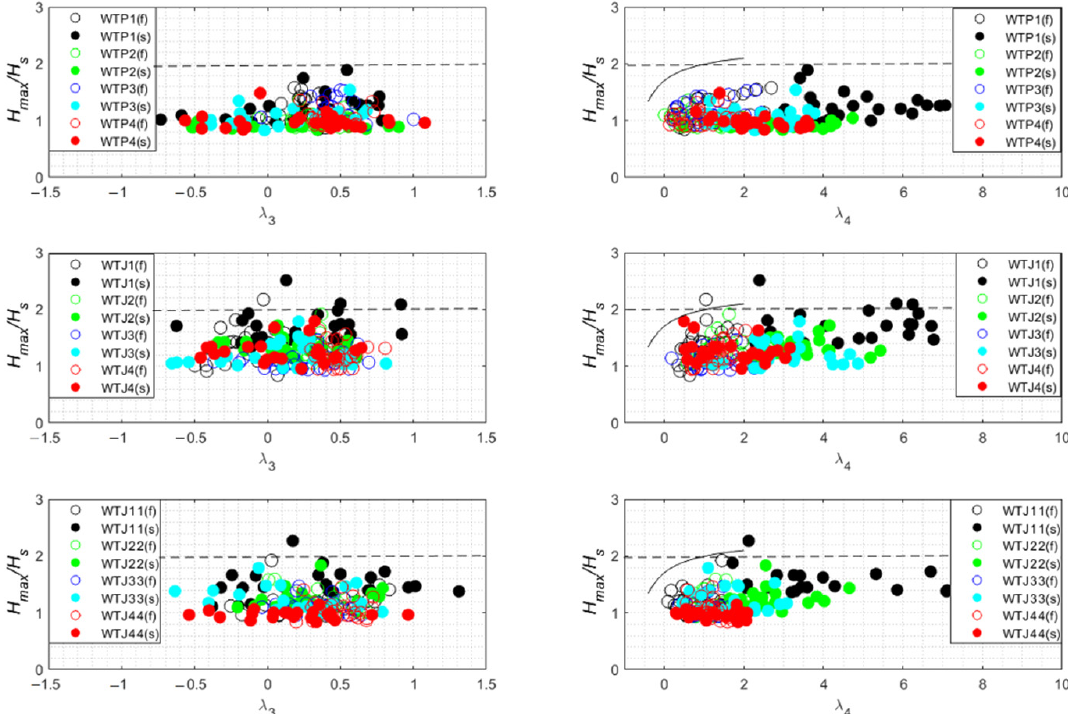
Figure 9. Relationship between the maximum wave height H max / H s , skewness 3 and kurtosis λ 4 on the flat and on the sloping bottom. Empty circles represent the flat bottom data (f) and filled circles exhibit the sloping bottom data (s). The solid black curve depicts the H max / H s empirical formulae proposed by [41].